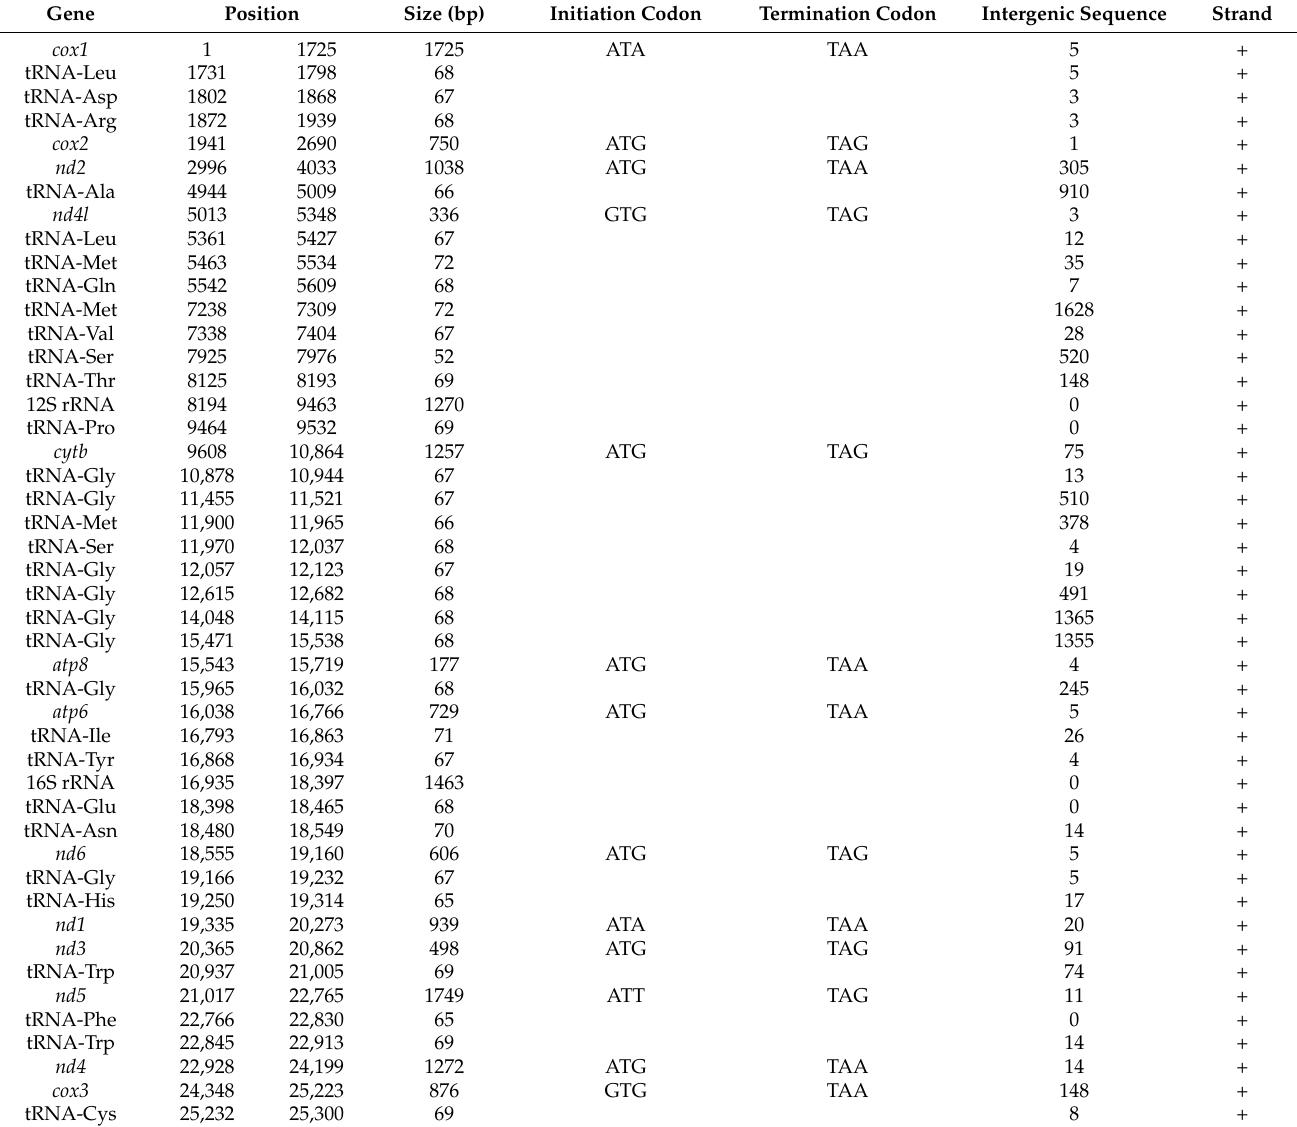
Table 2. Structure and orientations of Lingula anatina complete mitochondrial genome genes collected from Doson, Vietnam